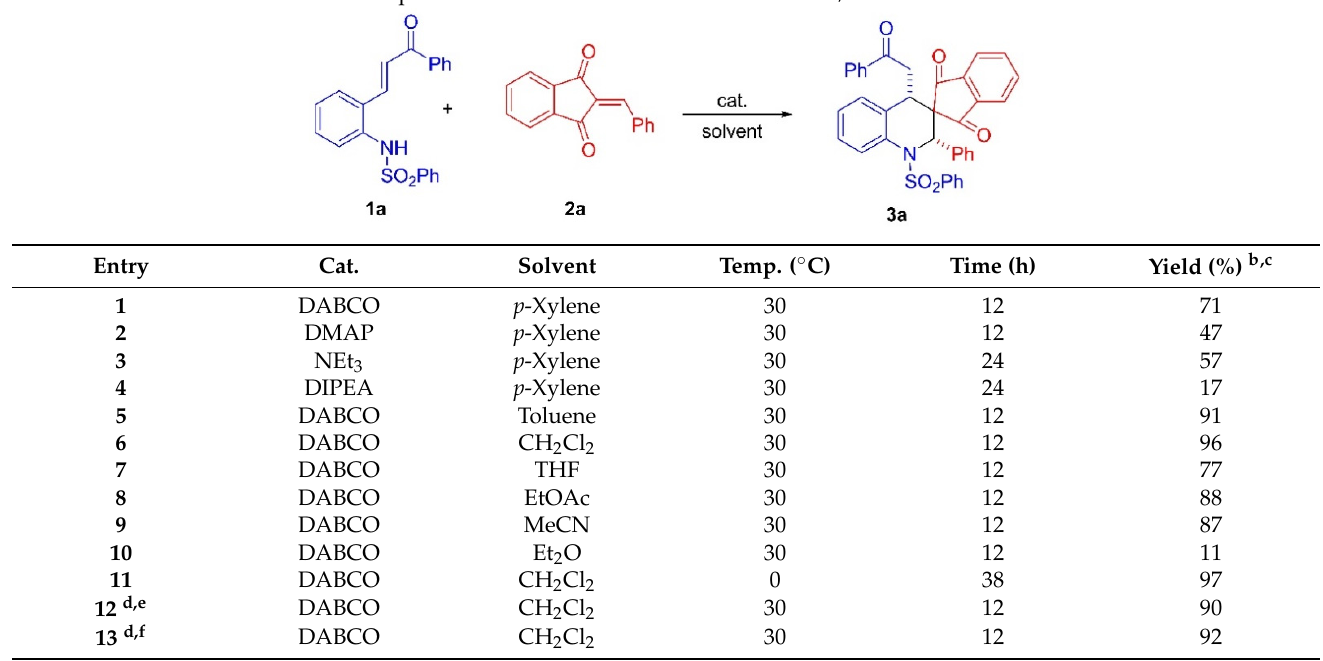
Table 1. Optimization of conditions of the aza-Michael/Michael reaction a .